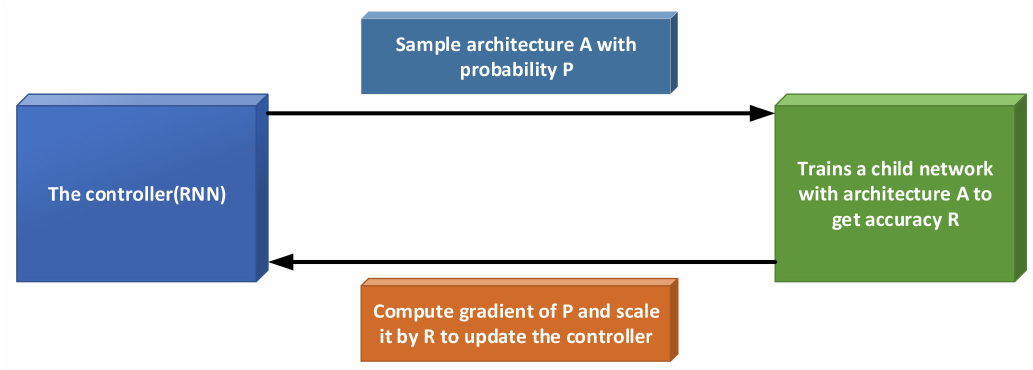
Figure 7. Controller reinforcement